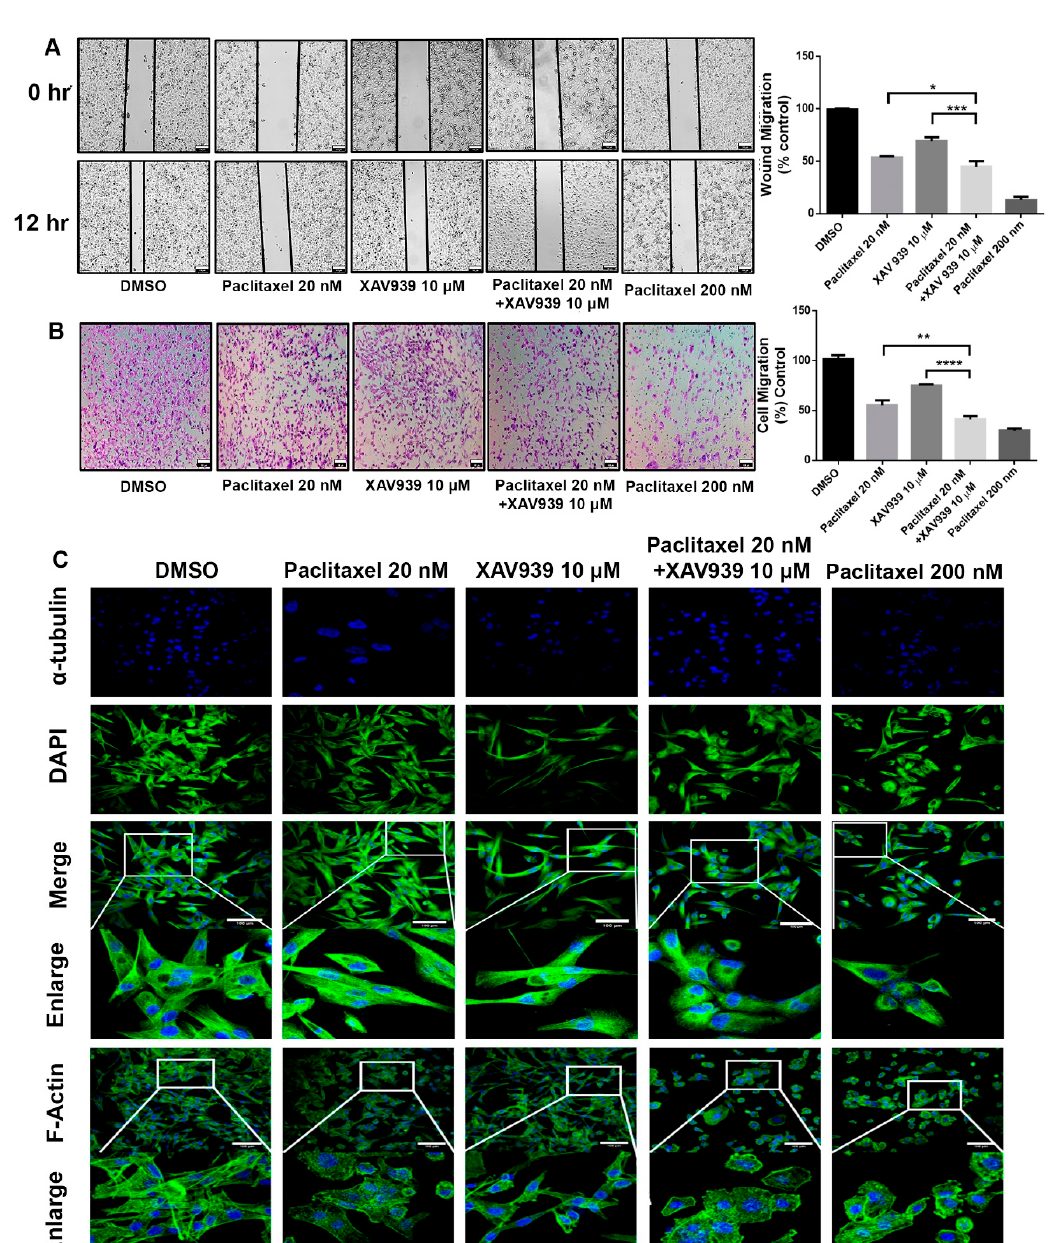
Figure 2. Combination treatment with paclitaxel (20 nM) and XAV939 (10 µM) inhibited the migration and invasion of MDA-MB-231 cells. ( A ) Cell scratch wound assay of MDA-MB-231 treated with paclitaxel and/or XAV939 for 12 h. Cells were photographed at a magnification of 4 × (t = 0 h, t = 12 h) and analyzed by the image-j software. ( B ) Invasion assay of MDA-MB-231 cells treated with paclitaxel and/or XAV939 for 24 h. Migrated cells were stained with crystal violet and photographed at five different areas at a magnification of 4 × . Colored cells were counted and analyzed statistically. ( C ) The cell integrity of MDA-MB-231 cells treated with paclitaxel and/or XAV939 for 48 h was examined via staining α -tubulin with anti- α -tubulin antibody. The actin disorganization in drug-treated MDA-MB-231 cells was examined using phalloidin (FITC) staining and observed under a confocal microscope. Data are presented as mean ± SD n = 3. *: p < 0.05; **: p < 0.001; ***: p < 0.0008, ****: p < 0.0001 in comparison to single treatment with either paclitaxel or XAV939. Scale bar = 100 µm.